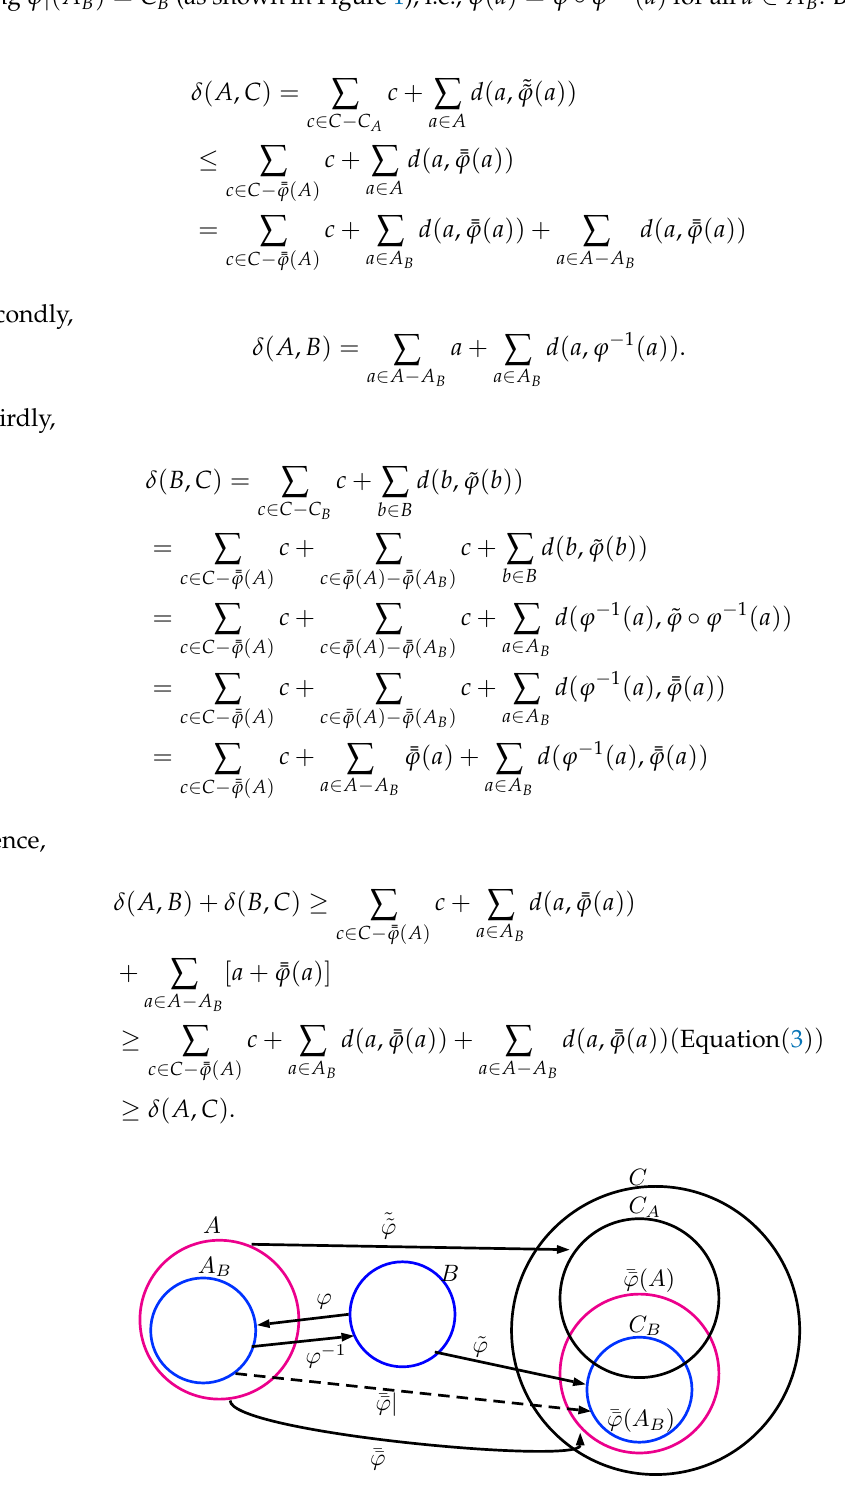
Figure 1. Triangle Inequality for ( 3,1,1 )